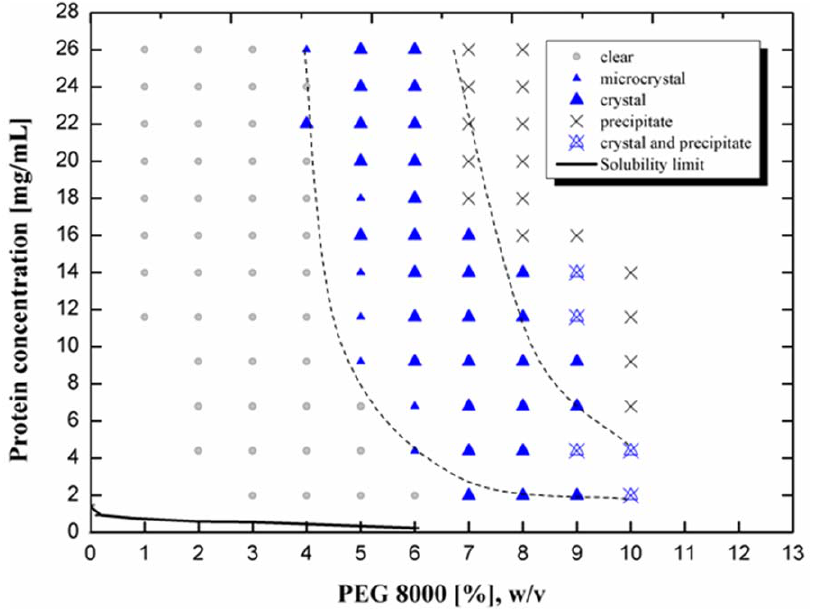
Figure 2. Phase diagram of mAb04c with PEG 8000 as precipitant. Buffer: 0.1 M imidazol, 0.2 M calcium acetate, pH 7.0, RT.